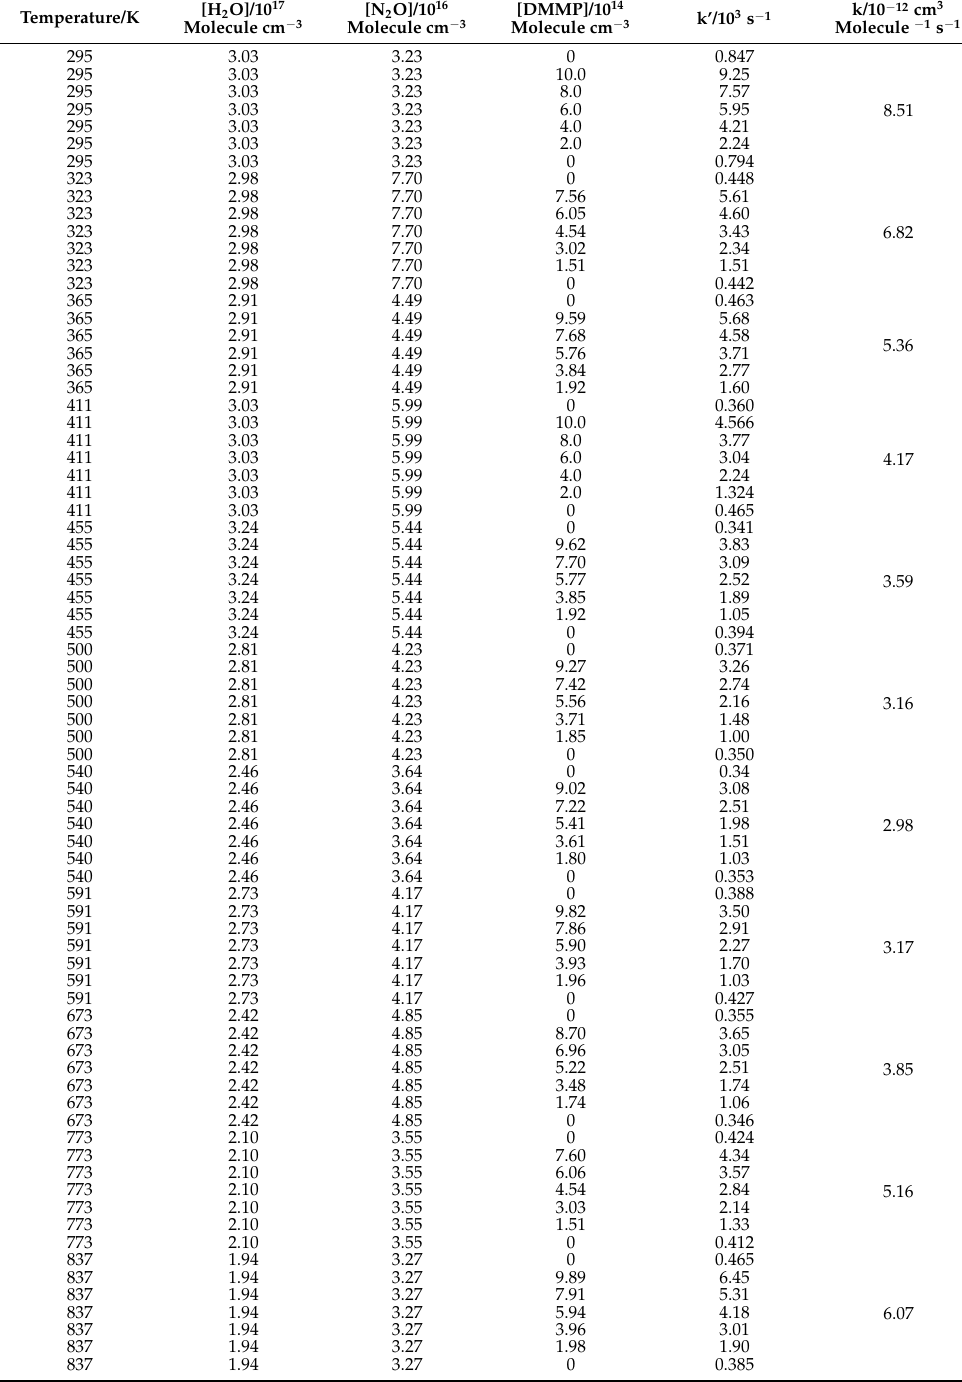
Table 2. Experimental conditions for the experiments with N 2 O/H 2 O/DMMP + 193.3 nm. All measurements at 1.00 ± 0.02 bar